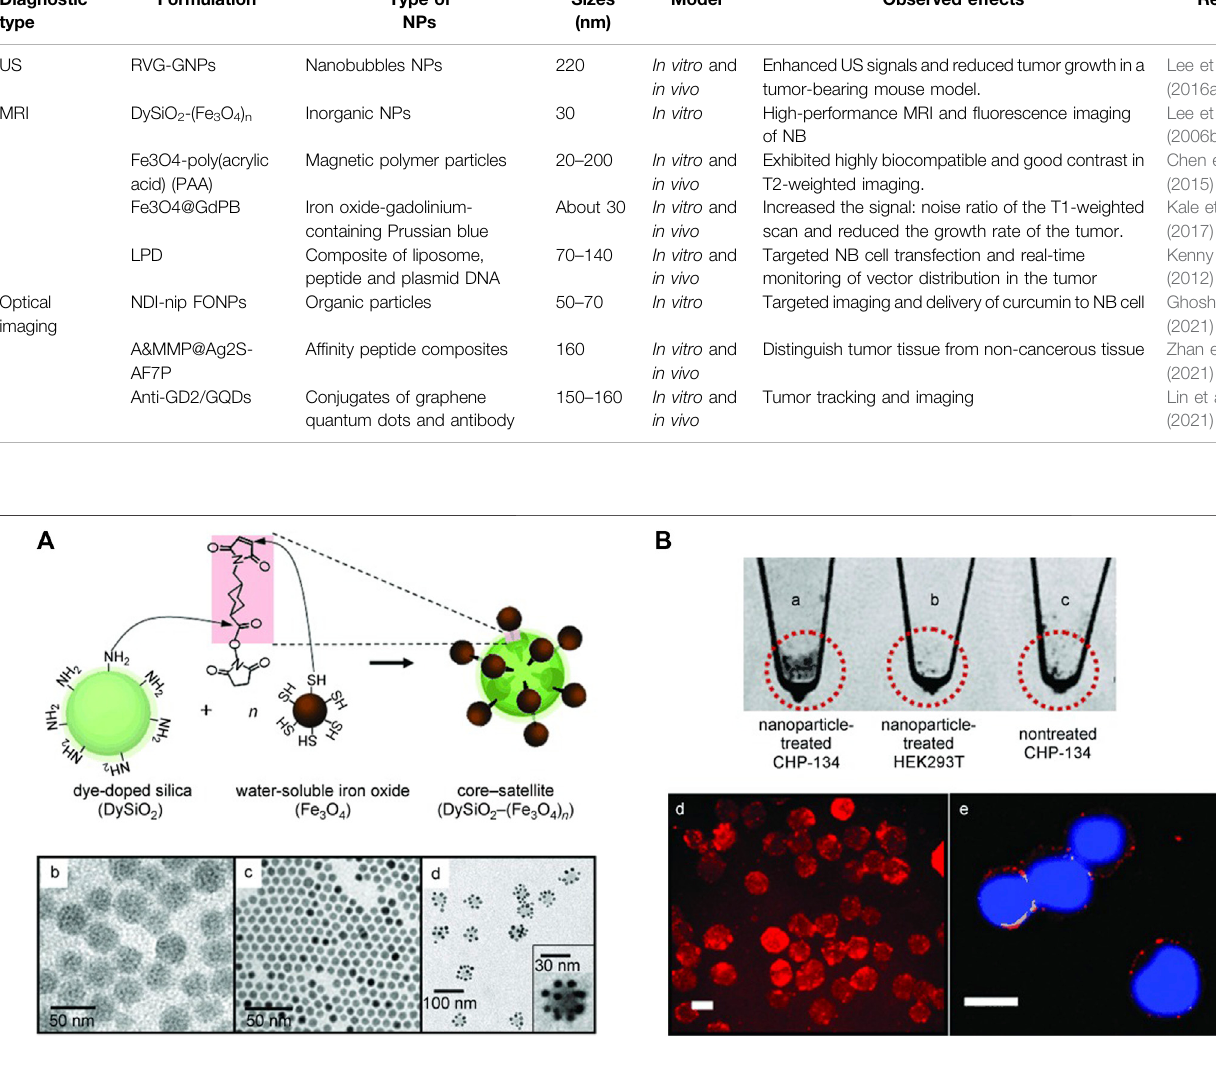
FIGURE 2 | Dual-Mode nanoparticle probes for high-performance magnetic resonance and fl uorescence imaging of NB. (A) Schematic diagram for the synthesis of core – satellite DySiO2 – (Fe3O4)n nanoparticles. (B) Dual-mode detection of PSAs. Reproduced with permission from (Lee et al., 2006a). Copyright 2006, Wiley-VCH Verlag GmbH & Co. KGaA,